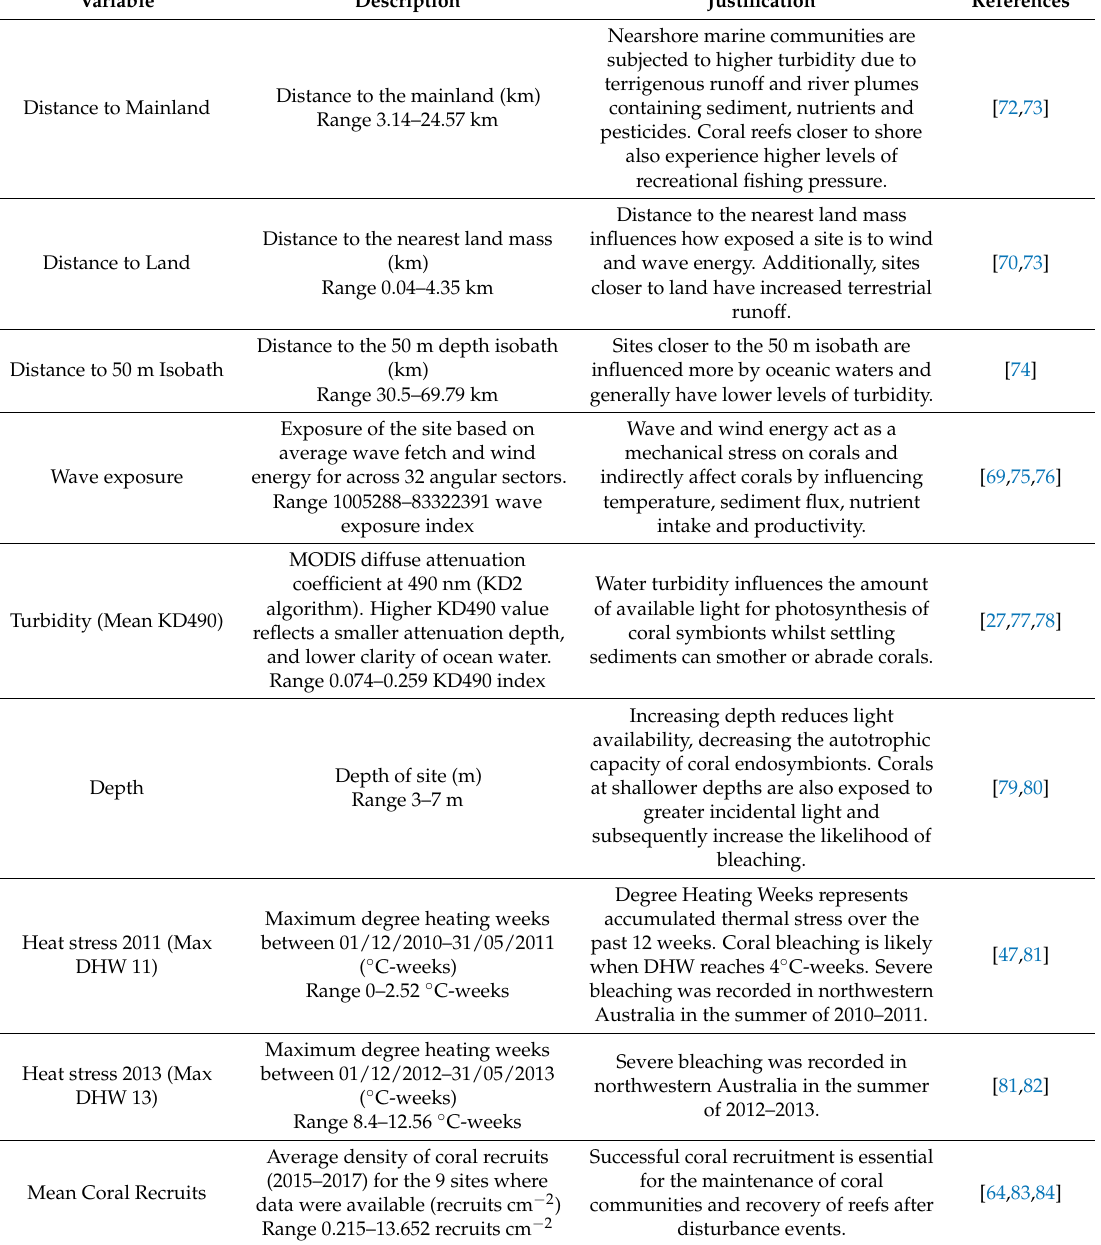
Table 1. Environmental variables included in the analysis of coral assemblage in the Dampier Archipelago, Western